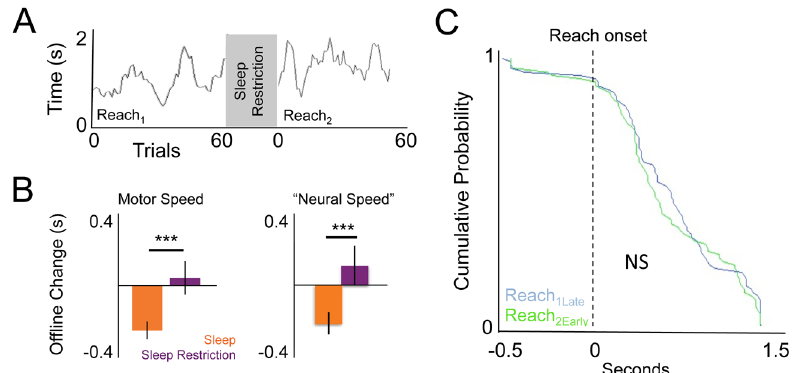
Fig 4. Sleep restriction prevents offline gains and temporal shifts. (A) Representative example of lack of improvement in speed after sleep-restriction (moving window average of 10 trials). (B) Comparison of effects of sleep restriction versus sleep ( n = 5 each) on changes in motor speed and “ neural speed ” (i.e., shift in PETH peak; n = 99 neurons from sleep animals, n = 80 neurons from sleep-restricted animals). Error bars show S.E.M. *** p < 0.001 (C) Cumulative distribution of single neuron peak of PETH (non-significant based on Kolmogorov Smirnoff test).